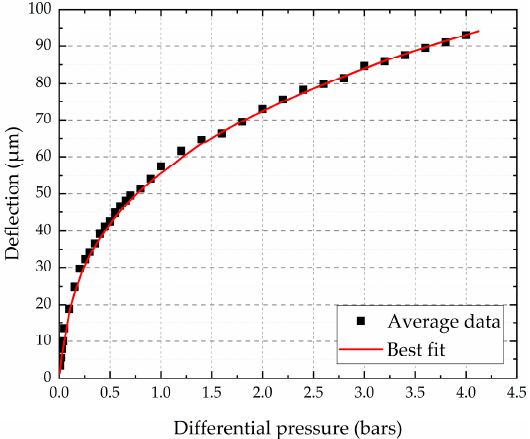
Figure 5. Dot line: Bulge test results for 4H-SiC diaphragm. Solid line: Theoretical fit. Table 2. Parameters used for both bulge test and finite element method (FEM) calculations.